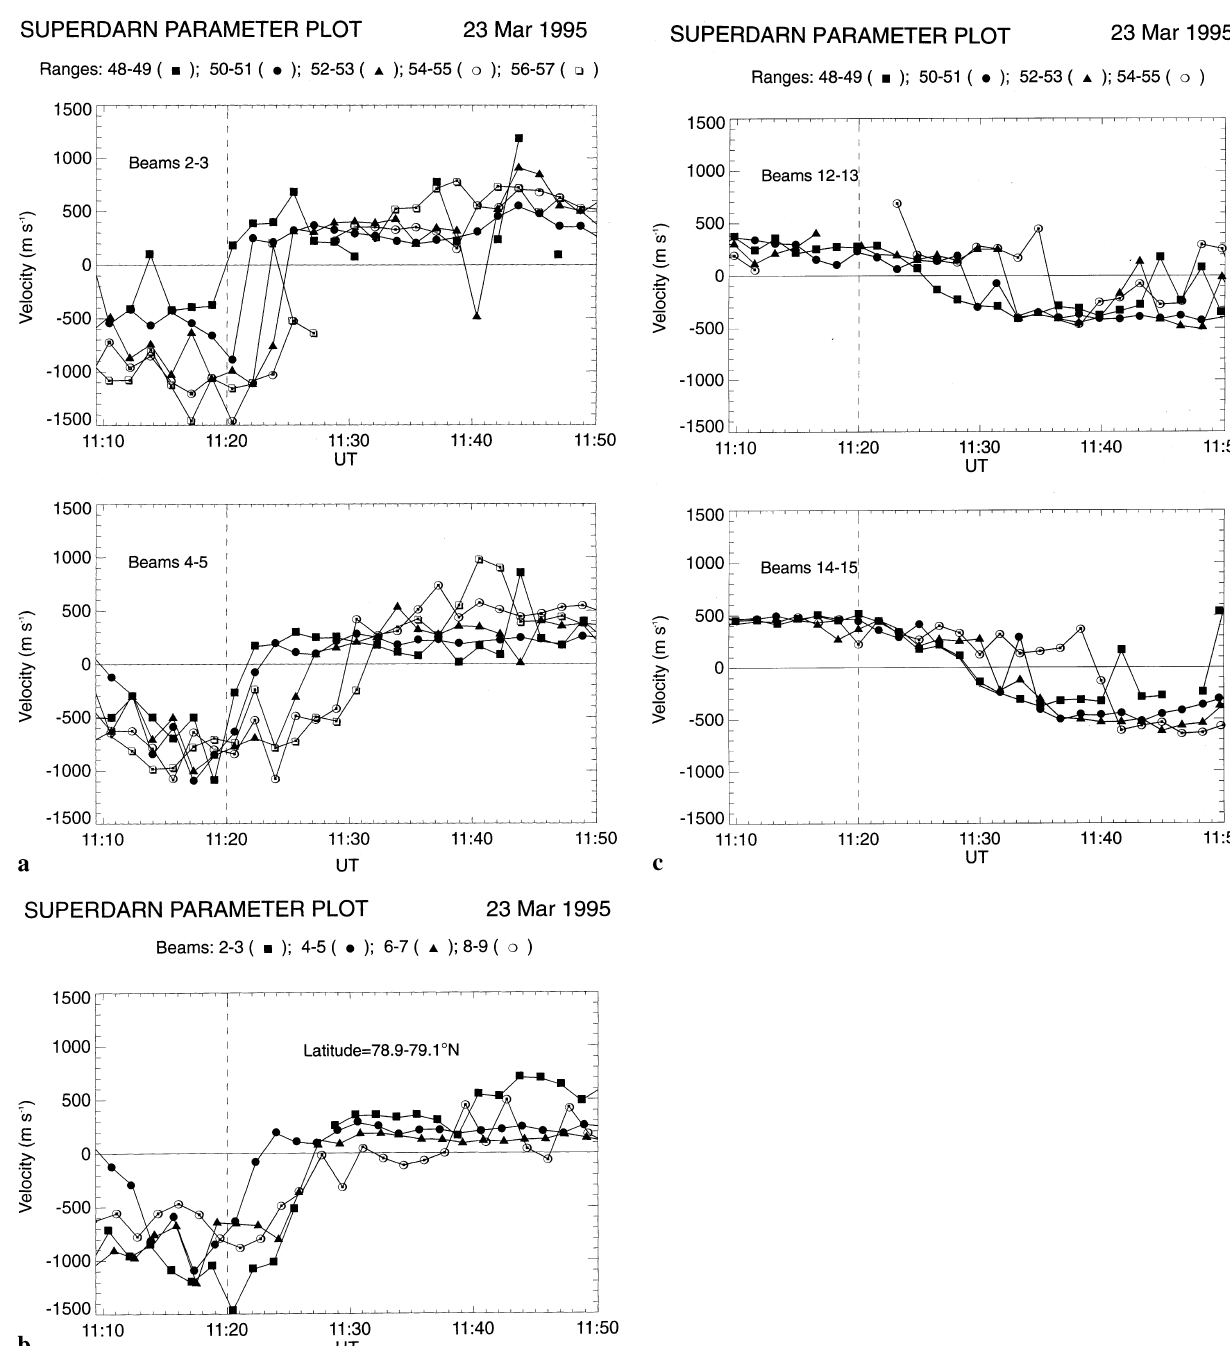
Fig. 8a–c. Time series plots of the averaged l-o-s velocities observed in selected 4-cell clusters of CUTLASS-Finland radar data, correspond- ing to two adjacent range gates along each of two adjacent radar beams. The time interval for each plot is 1110–1150 UT, and the dashed vertical line at 1120 UT represents the start of the 20 min interval of flow reconfiguration. Positive l-o-s velocities indicate flow towards the radar (approximately sunward), while negative velocities indicate flows away from the radar (approximately antisunward). a Shows data from successive range gate pairs of beams 2–3 ( upper panel ) and 4–5 ( lower panel ), showing the poleward progression of the flow transition from antisunward to sunward flow in the noon sector.